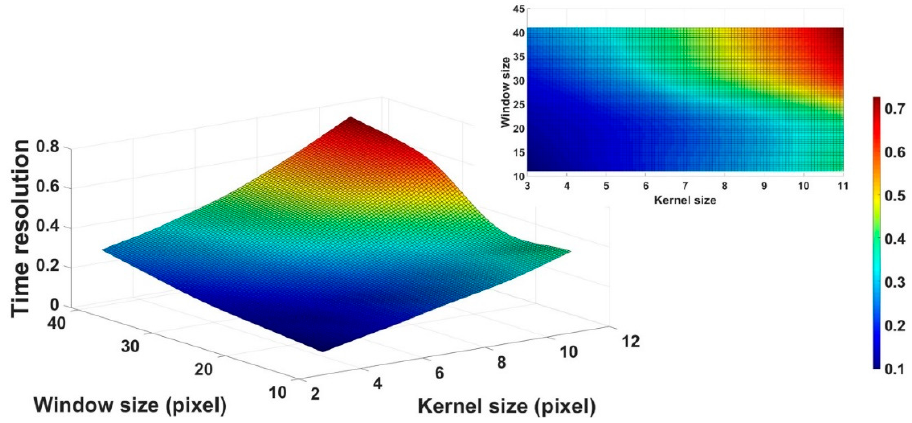
Figure 6. Time resolution results of the FNLM algorithm with various search window and kernel sizes.